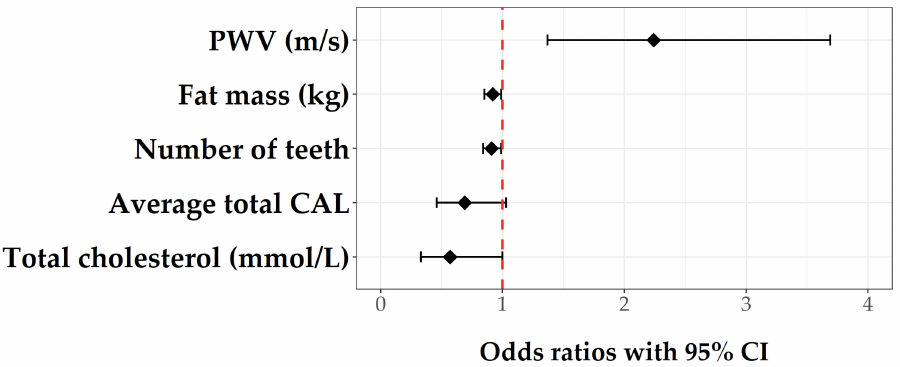
Figure 3. Most important predictors of atherosclerosis in KTRs (final model). Abbreviations: PWV, pulse wave velocity (m/s); CAL, clinical attachment loss; CI, confidence